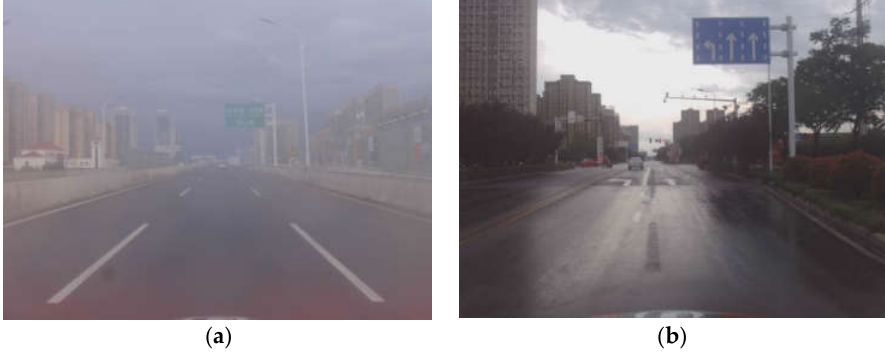
Figure 23. Test site on rainy day: ( a ) city expressway; ( b ) ordinary urban road.